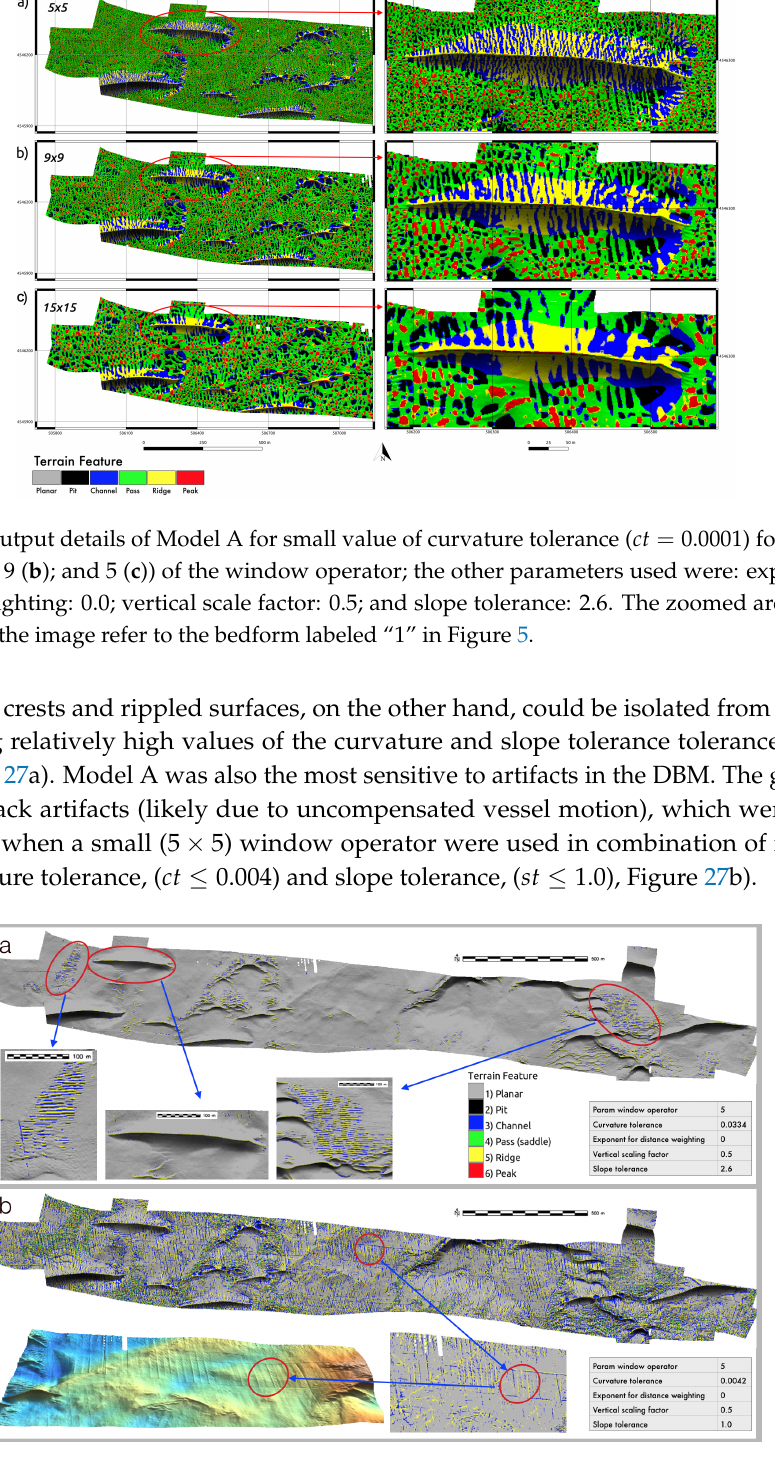
Figure 27. Output details for Model A : ( a ) for high value of curvature and slope tolerance ( ct = 0.0334; st = 2.6), the model depicted rippled areas as well as dune crests; ( b ) for low value of curvature and slope tolerance ( ct = 0.004; st = 1.0), the model depicted small artifact ( height ≤ 20 cm). In ( b ), the 3D perspective view of the MBES dataset (vertical exaggeration: 3 × ) is illuminated with a light source directed from east to west (along track direction) to highlight the small ( height ≤ 20 cm) across-track artifacts likely due to uncompensated vessel